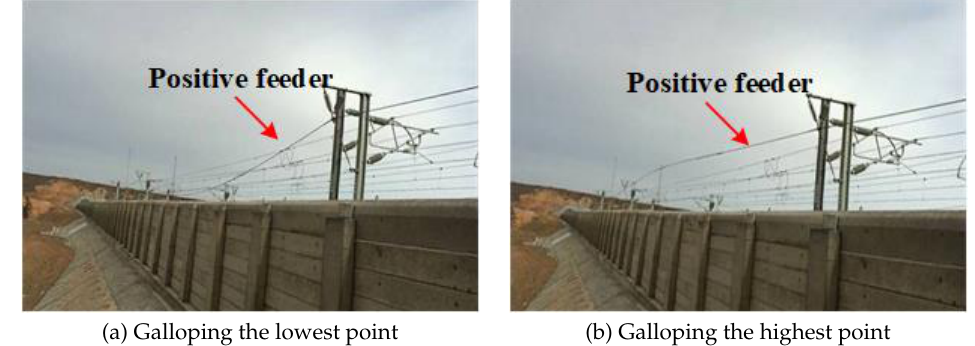
Fig. 1. Catenary positive feeder galloping of Lanzhou-Urumqi high-speed railway in Baili gale